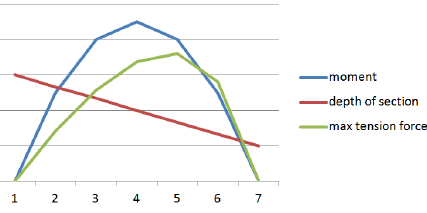
Figure 14: the moment in a beam varies with x 2 . With a reduction in a section depth, the maximum tension and compression forces is shifted towards the shallower